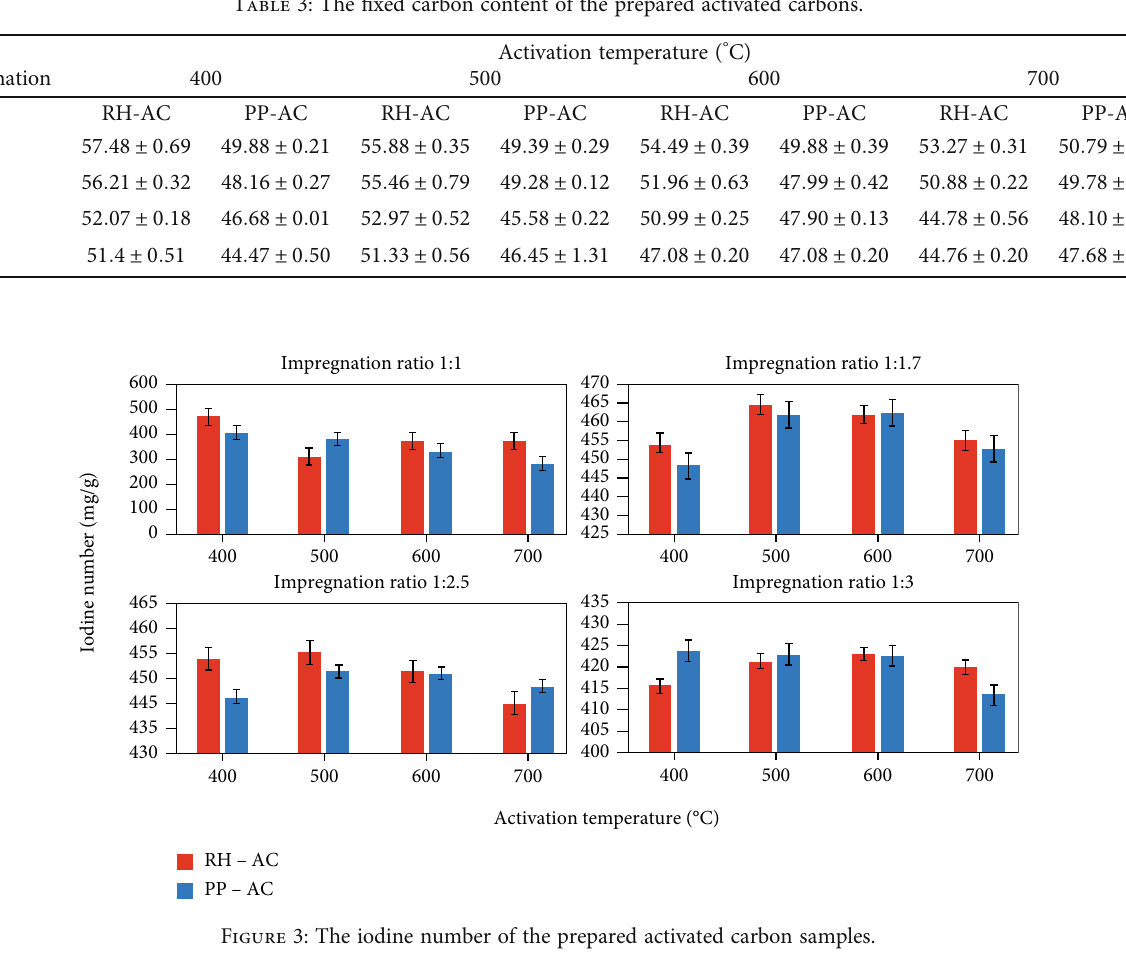
Table 3: The fi xed carbon content of the prepared activated carbons.